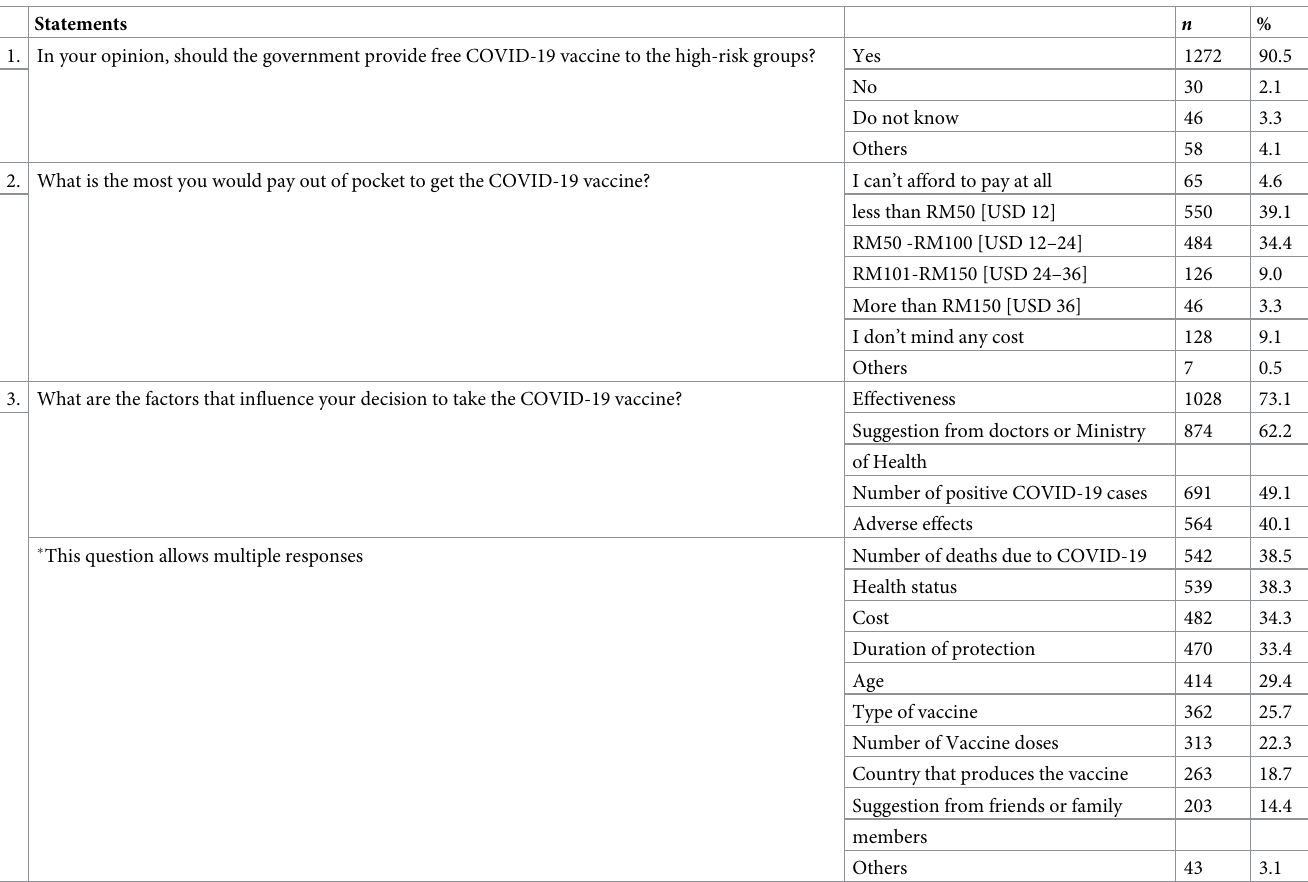
Table 4. Questions on factors influencing acceptance for COVID-19 vaccine (N =